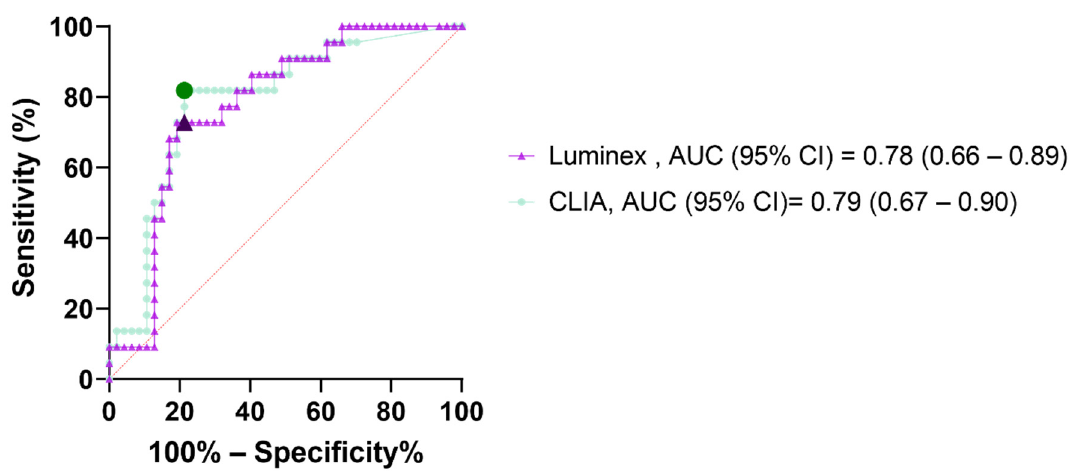
Table 1: CRP ( p < 0.01) and D-dimer ( p = 0.03).